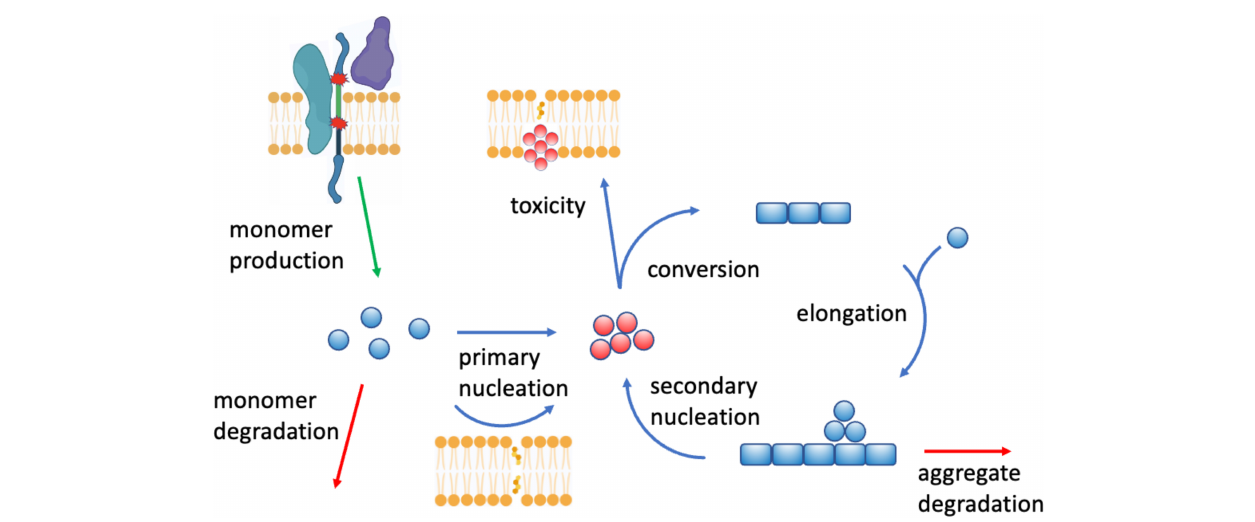
FIGURE 5 | Crosstalk between perturbed lipid homeostasis and A β aggregation in Alzheimer’s disease. There are at least three aspects of this crosstalk: (1) lipids affect A β homeostasis in a number of ways, for example by modulating the concentration A β monomers by regulating the activity of the secretases (top left) involved in the proteolytic cleavage of A β from APP (Di Paolo and Kim, 2011; Haass et al., 2012; Crivelli et al., 2020) (“monomer production”), of the endopeptidases (“monomer degradation”) that degrade A β monomers (Yao et al., 2008), and of the endolysosomal system that removes A β aggregates (Morel et al., 2013) (“aggregate degradation”), (2) lipid membranes of altered composition (cholesterol (Habchi et al., 2018) and gangliosides (Matsuzaki, 2020)) can trigger A β aggregation by promoting the formation of disordered oligomers (in red) “primary nucleation”), which then grow into amyloid fibrils (Michaels et al., 2020) (“conversion,” “elongation,” and “secondary nucleation”), and (3) A β aggregates, including oligomers, can in turn compromise lipid homeostasis, including by perturbing lipid membranes by binding to them (“toxicity”), or by disrupting lipid signaling by binding membrane receptors (Haass and Selkoe,